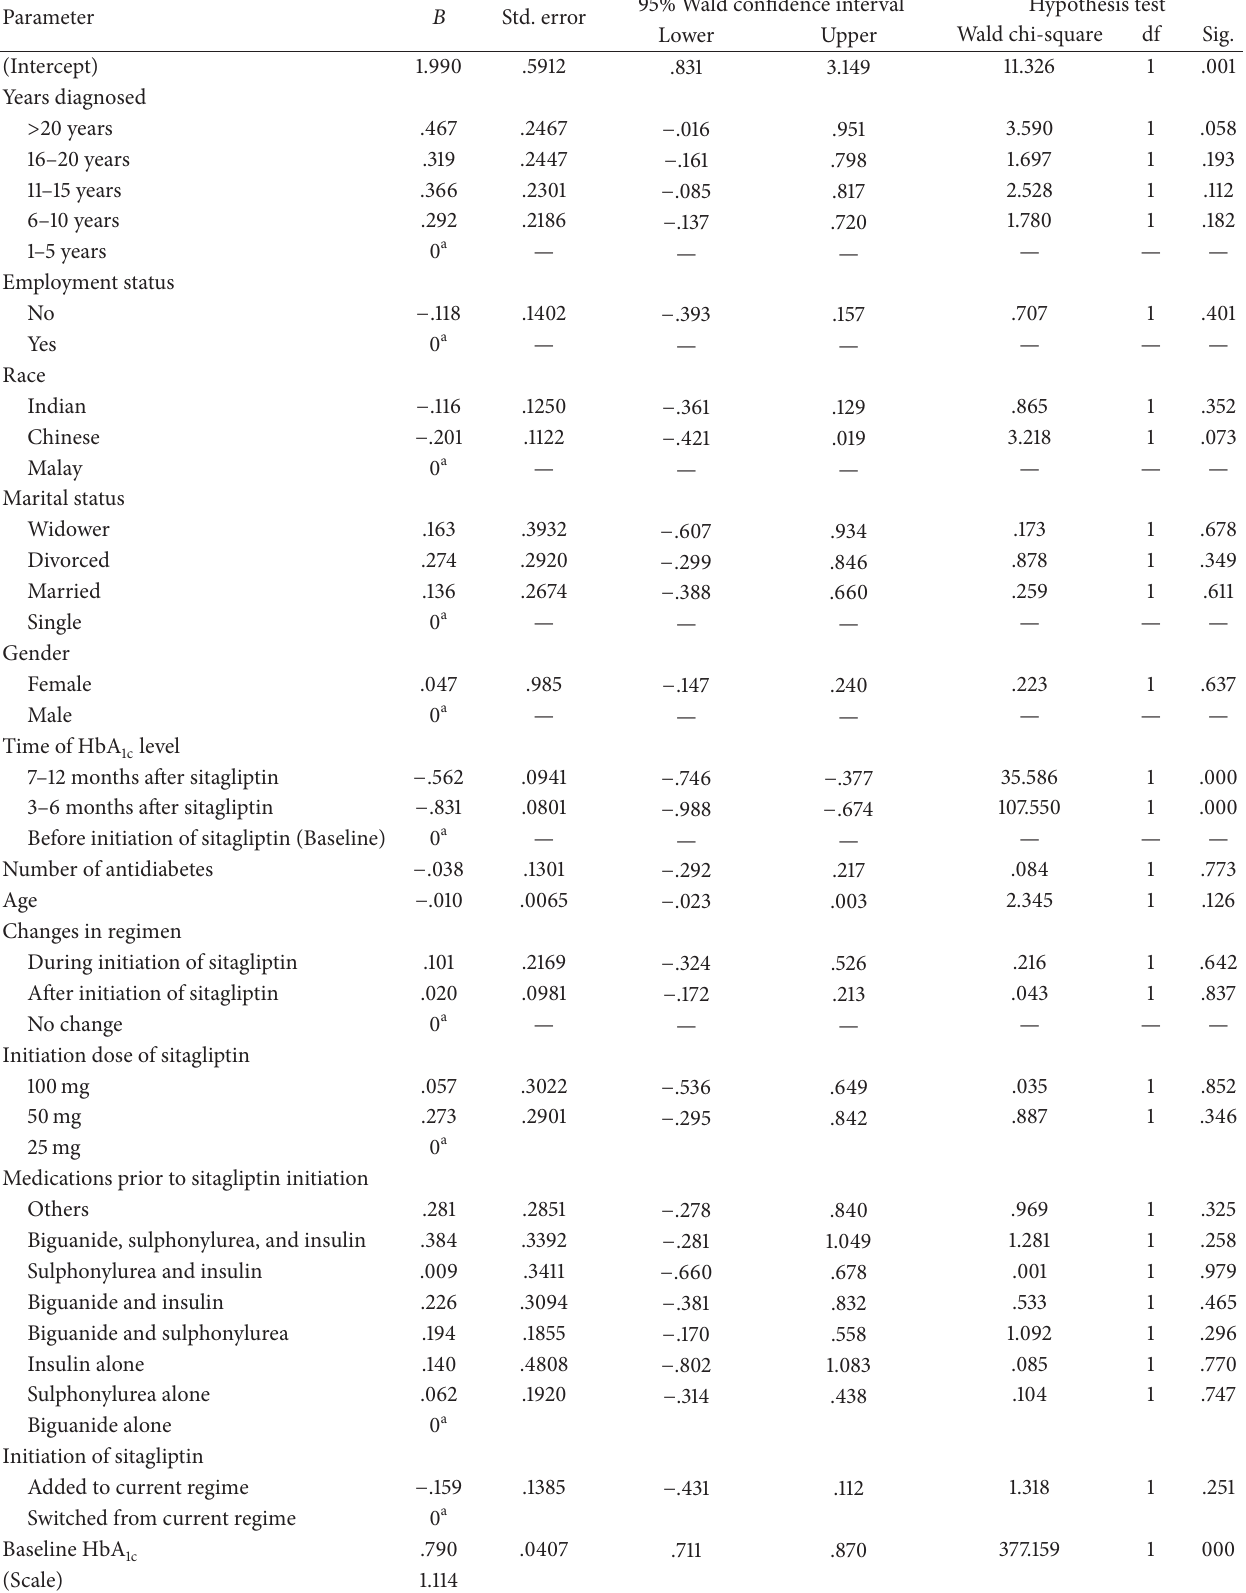
Table 2: Parameter estimates using the Generalized Estimating Equations (GEE) model (imputed) ( 𝑁 = 244